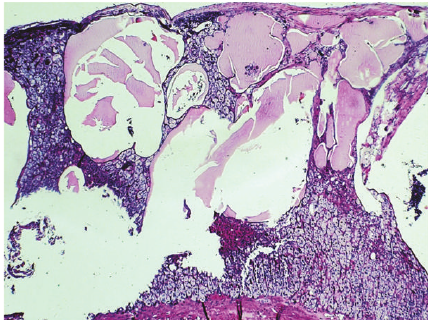
Figure 1: T1-weighted MRI image of adrenal lymphangioma in coronal section.